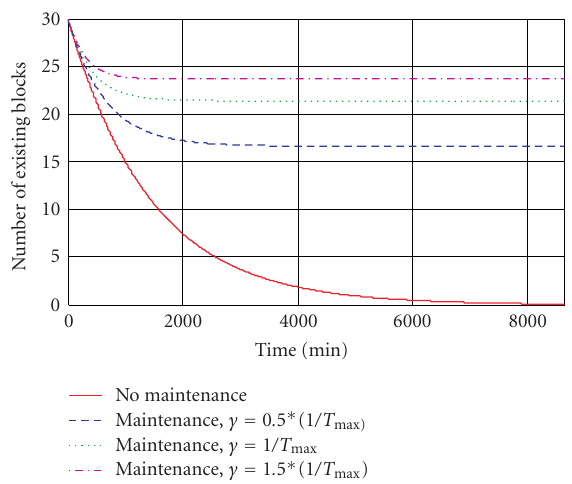
Figure 9: Number of holders. r = 30, k = 5, v = 10, k (cid:2) = 7,